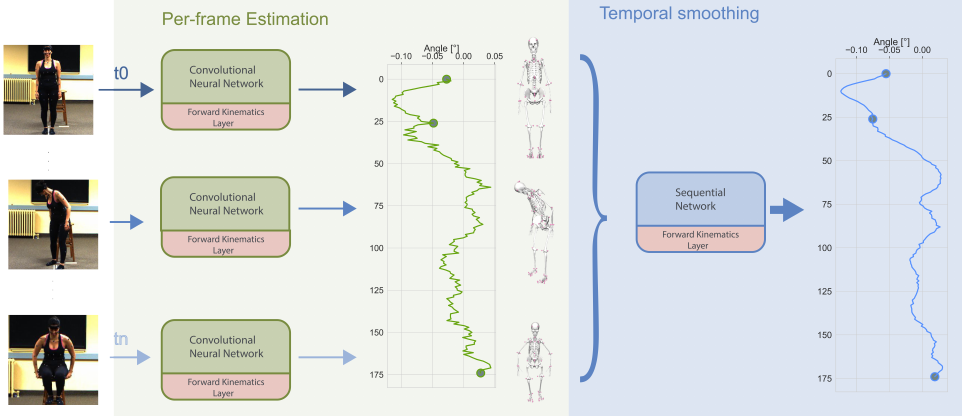
Figure 2. Taking a single view video as input, D3KE consists of one convolutional neural network and one sequential network. Per frame, D3KE outputs joint angles and scales of individual bones in a skeletal model(scale factors) with a convolutional network. Additionally, joint angle and scale factor are converted to a pose through the skeletal-model kinematics (SM) layer. A series of frame estimations in time are then fed into a sequential network to smooth the estimations and reduce artifacts if one limb occludes another in the view of the camera